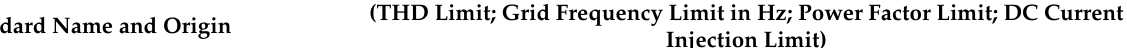
Table 2. Grid codes and grid-connected PV system standards